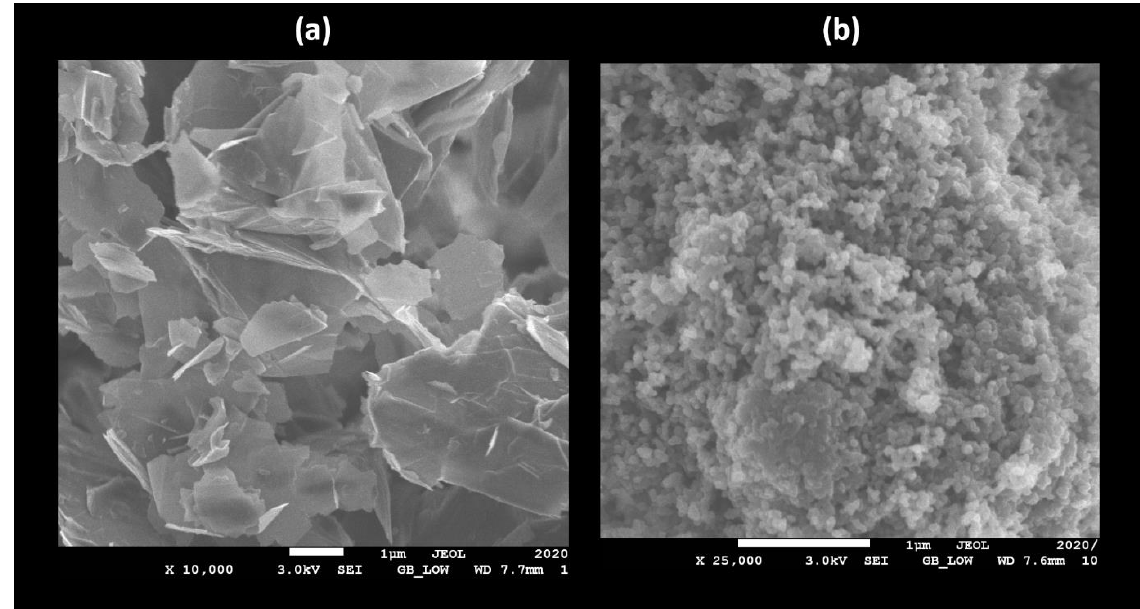
Figure 2. SEM graphs of ( a ) Gr and ( b ) PPy. CB 20% .